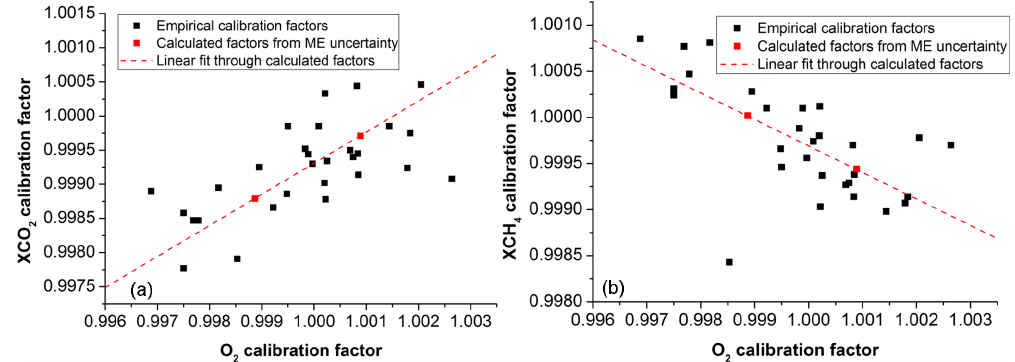
Figure 12. Correlation of O 2 calibration factors and XCO 2 (a) as well as XCH 4 (b) calibration factors. Black squares show the empirical calibration factors from the side-by-side measurements, red squares show calculated factors derived from the total ME uncertainty shown in Table 1, and the dashed red line is a linear fit through the calculated factors. The slope of empirical and calculated factors is in good